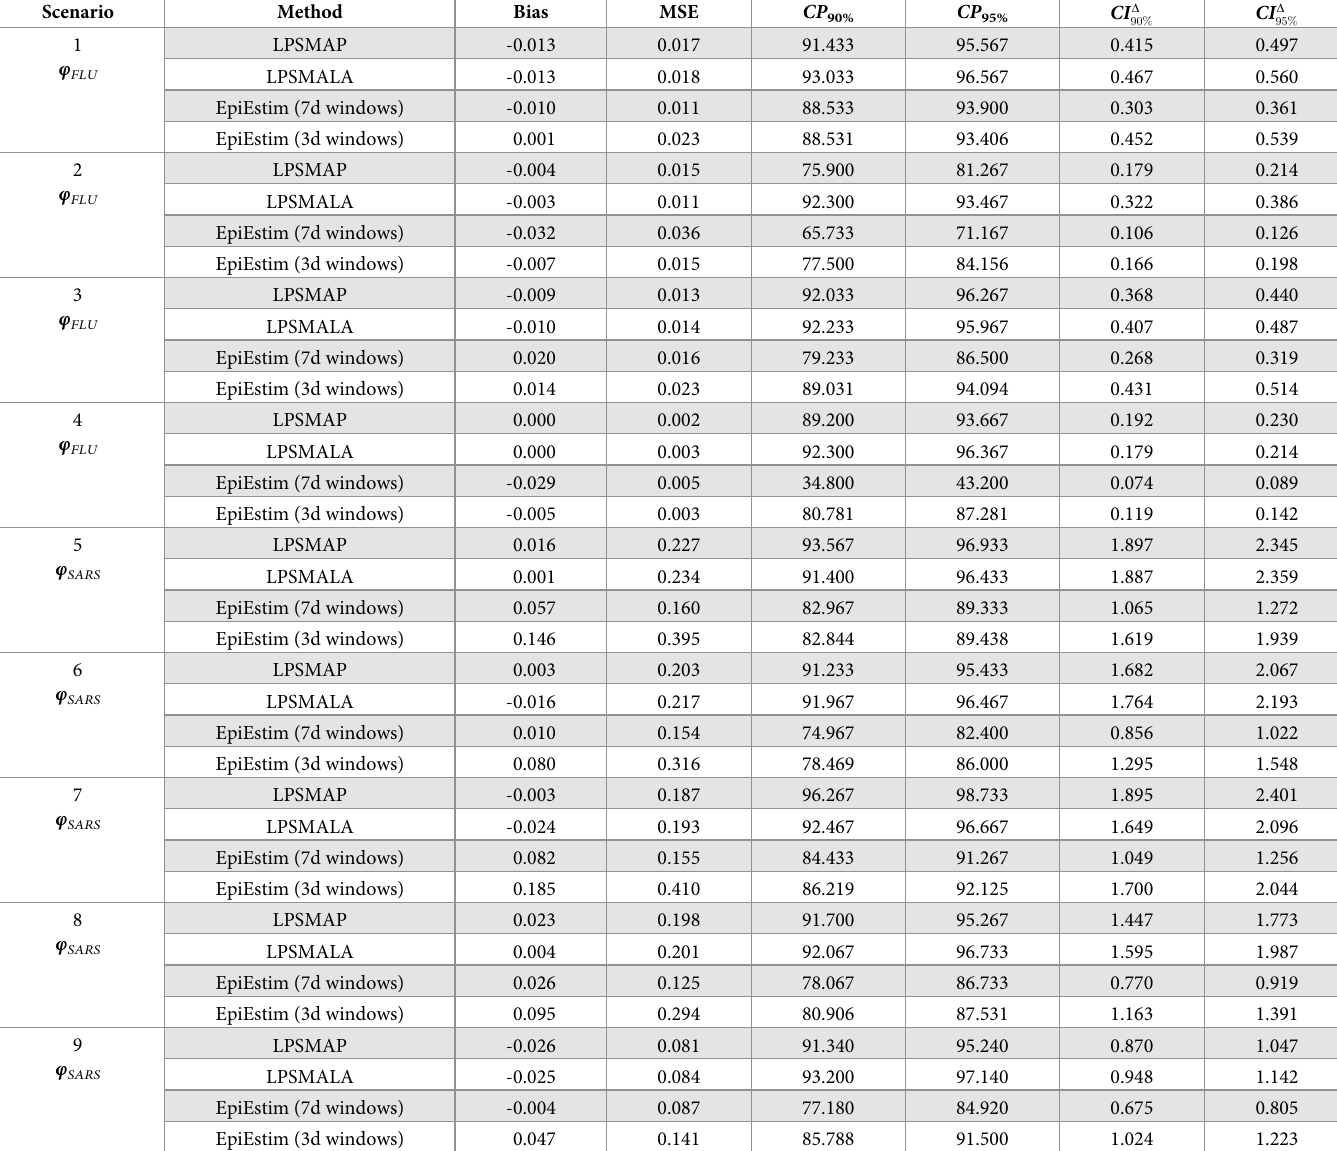
Table 4. Simulation results for EpiLPS and EpiEstim in Scenarios 1–9 for S = 100 simulated epidemics. The performance indicators in Scenarios 1–8 for R aged over days t = 8, ... ,37 for LPSMAP, LPSMALA and weekly windows (EpiEstim) and over days t = 8, ... ,39 for 3 days windows under EpiEstim. In Scenario 9, the per- formance indicators for R are averaged over days t = 8, ... ,57 for LPSMAP, LPSMALA and weekly windows (EpiEstim) and over days t = 8, ... ,59 for 3 days windows t under EpiEstim. For EpiEstim, R is reported at the window t